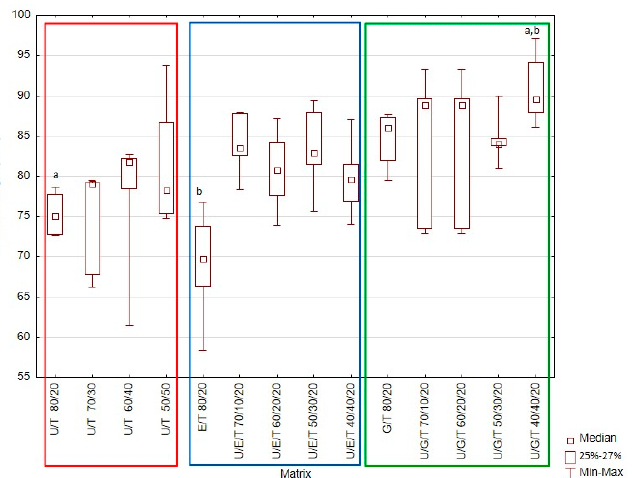
Figure 1. Box-and-whisker plot of three-point bending flexural strength (FS). For variables with the same letter (a,b), the difference is statistically significant ( p ≤ 0.05). Materials 2021 , 14 , 2727